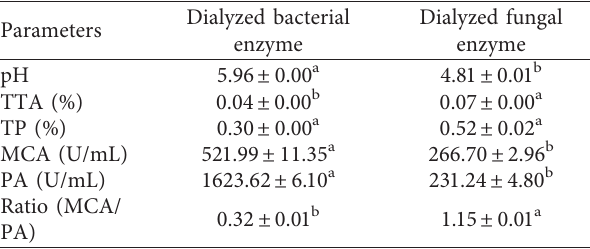
Table 2: Characteristics of the dialyzed bacterial and fungal enzymes.